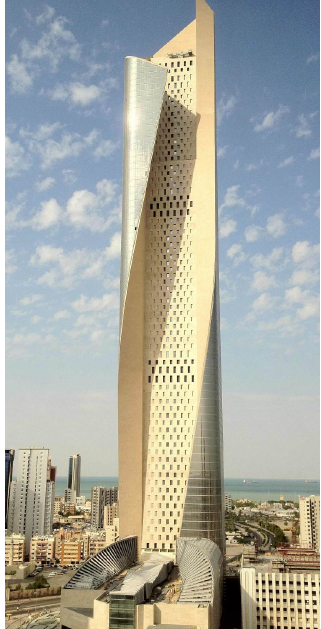
Figure 6. Al Hamra Tower (source: